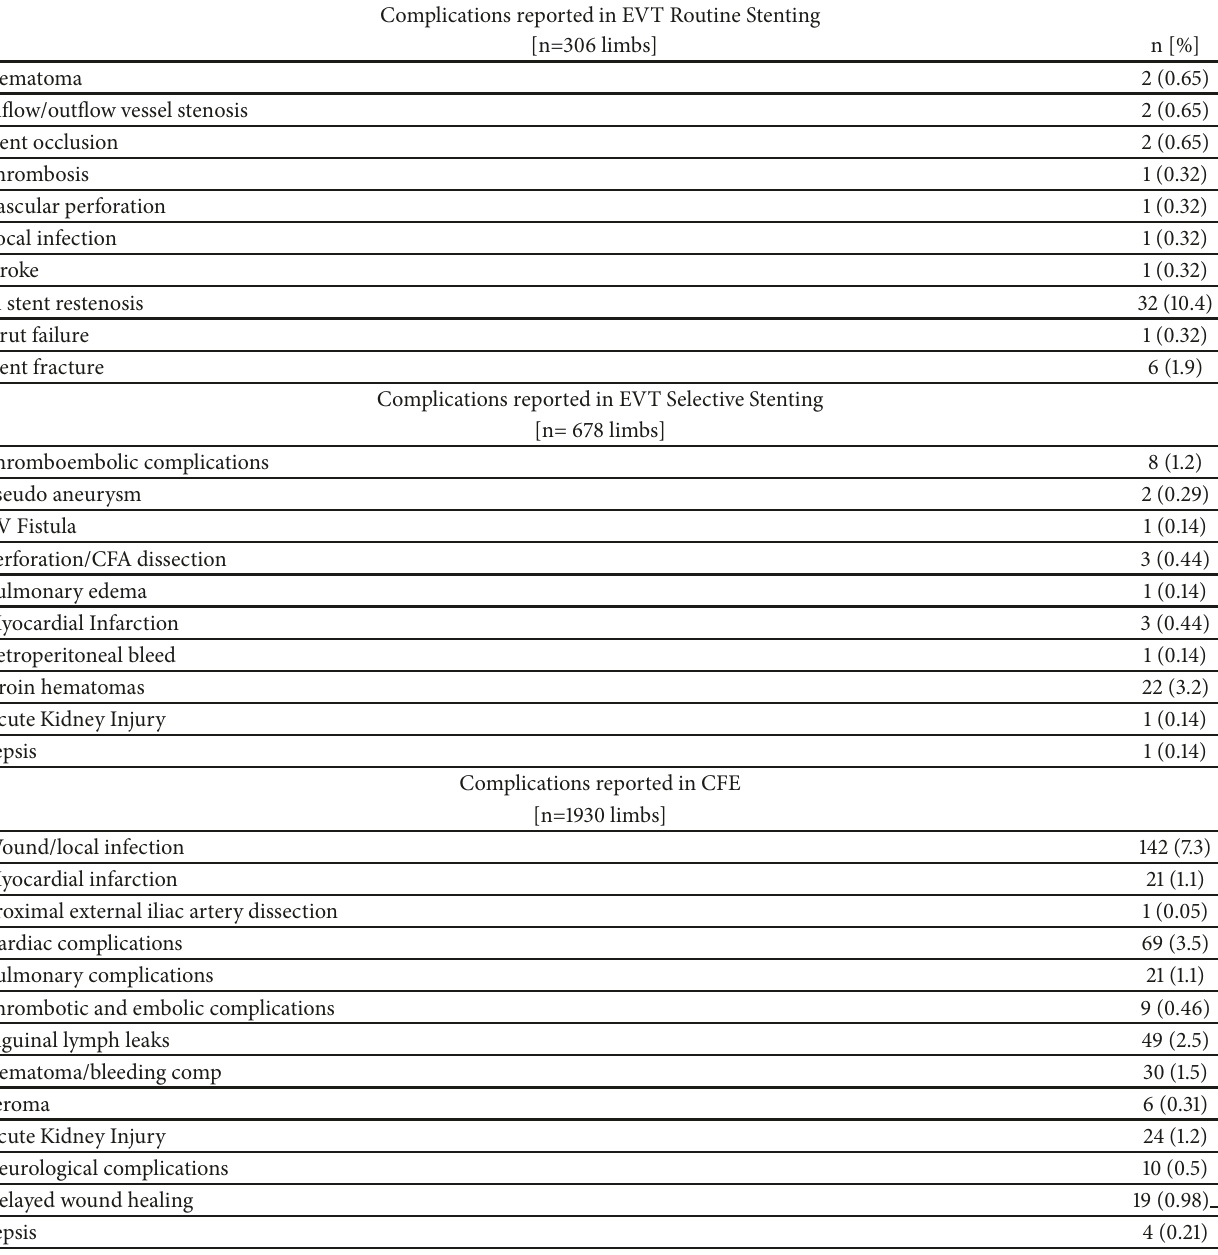
Table 6: Details of